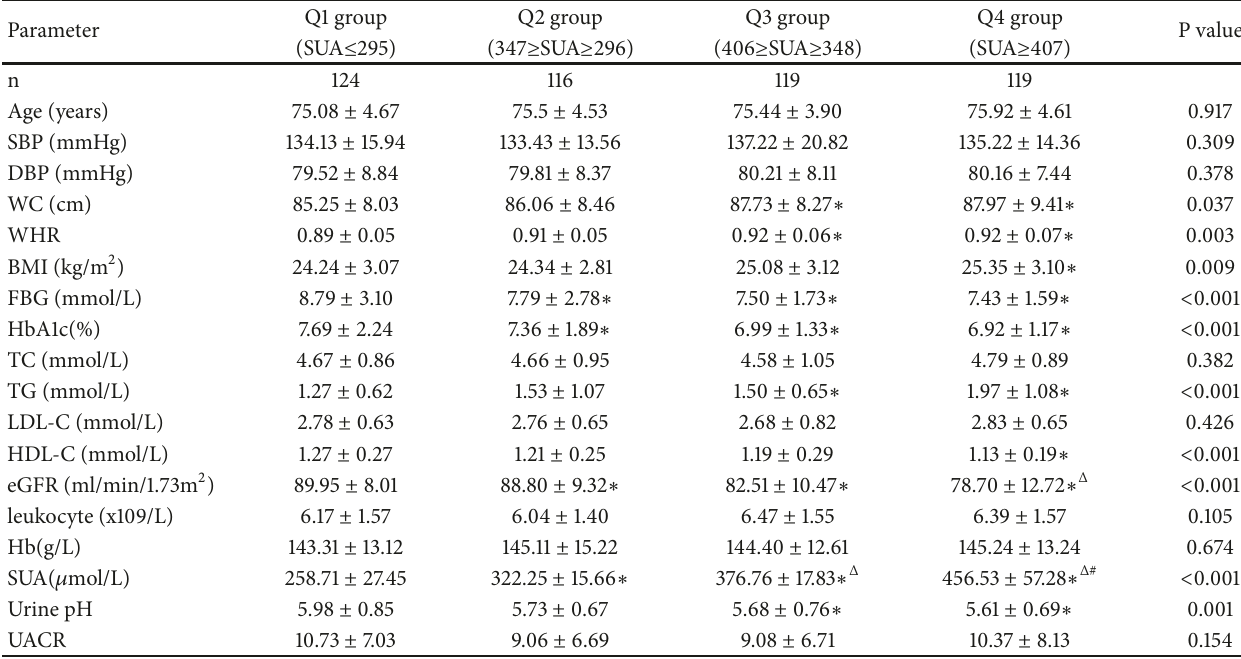
Table 2: Clinical data in male patients according to SUA quartile.